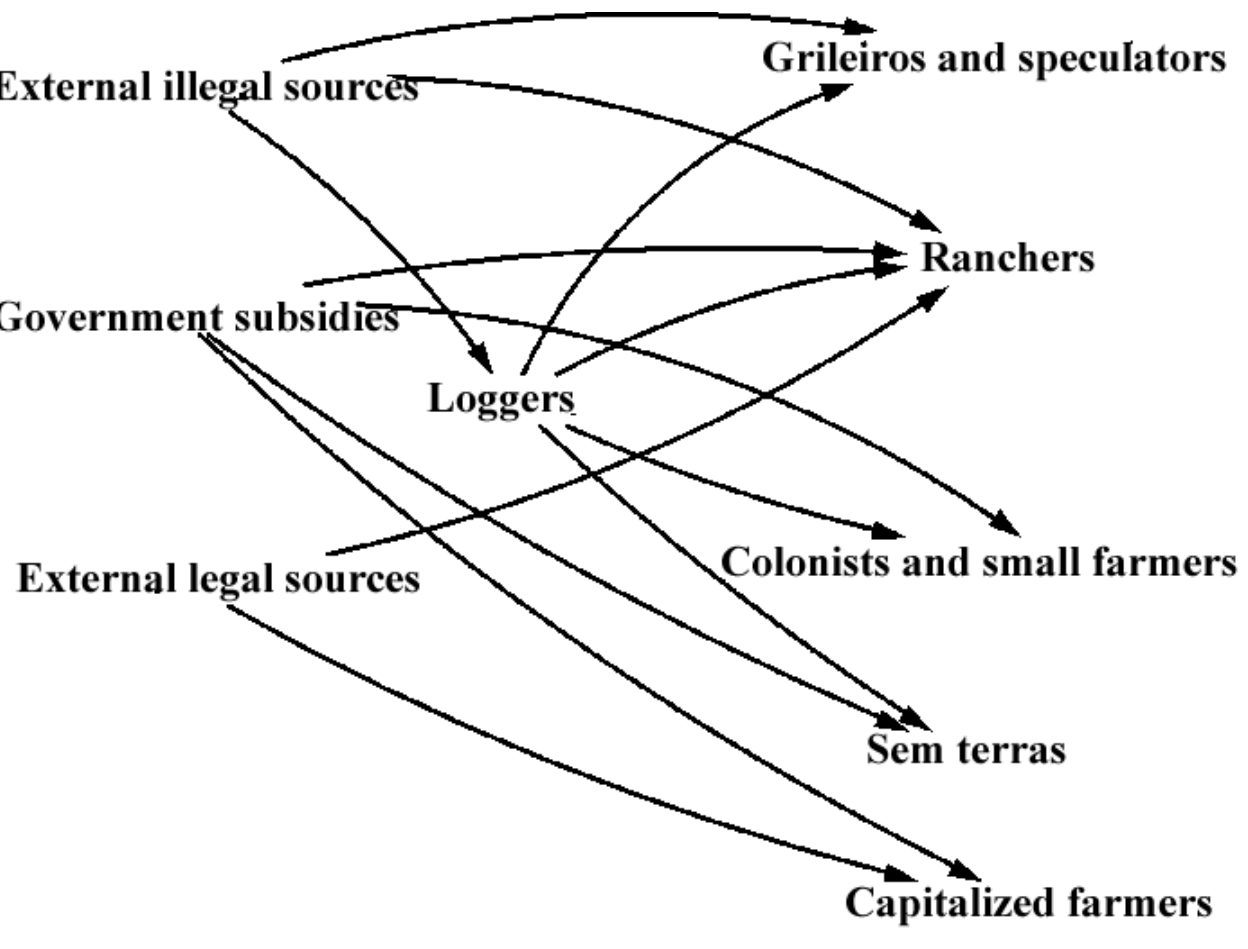
Fig. 4. Money flows: major financial flows to and among